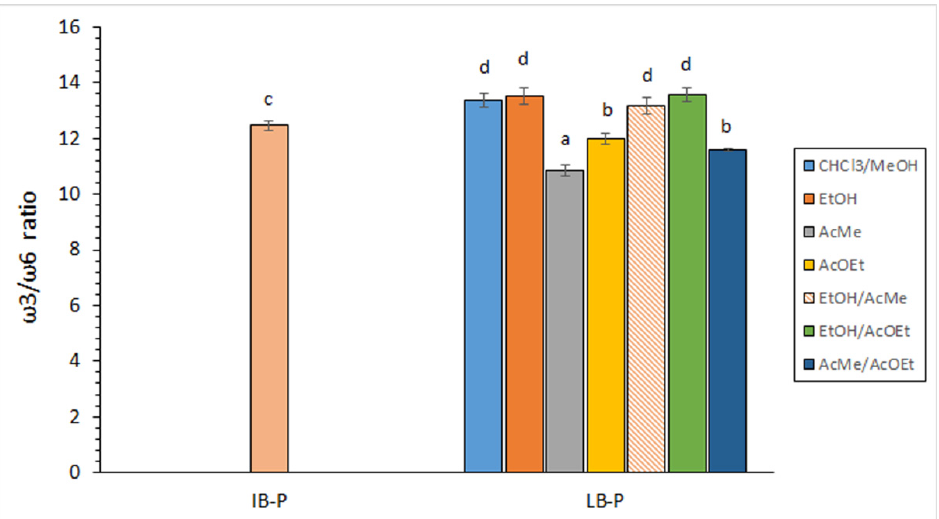
Figure 3. Determination of the ω 3/ ω 6 ratio in initial by-products (IB-P) and lyophilised by-products (LB-P) obtained by different lipid-extracting systems. Average values of three independent determinations ( n = 3); standard deviations are indicated by bars. Values accompanied by different lowercase letters (a–d) indicate significant differences ( p < 0.05). Extracting systems as expressed in Table 1.